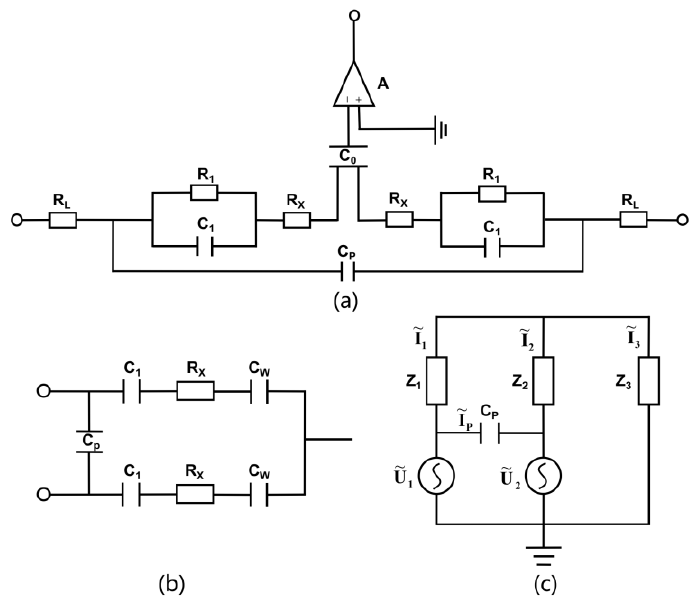
Figure 3. The equivalent circuit models of DISODCD. ( a ) Original equivalent circuit of DISODCD; ( b ) Simplified equivalent circuit of DISODCD; ( c ) The equivalent circuit of DISODCD used by the superposition theorem.